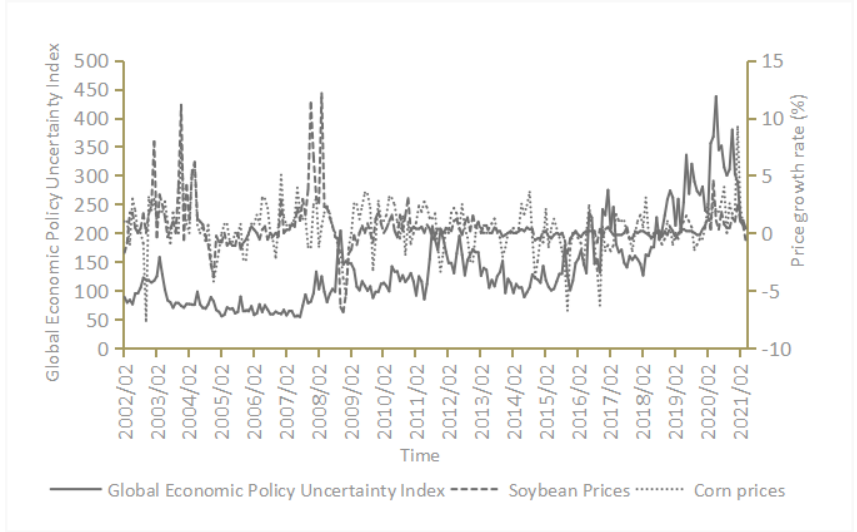
Figure 1. Global economic policy uncertainty index and soybean and corn price growth rates. Sources: The graph shown above is the author ’ s plot based on the above data. The data of the corn and soybean prices come from the Brick Agricultural Database. The data of the global economic policy uncertainty index come from the Economic Policy Uncertainty Website.